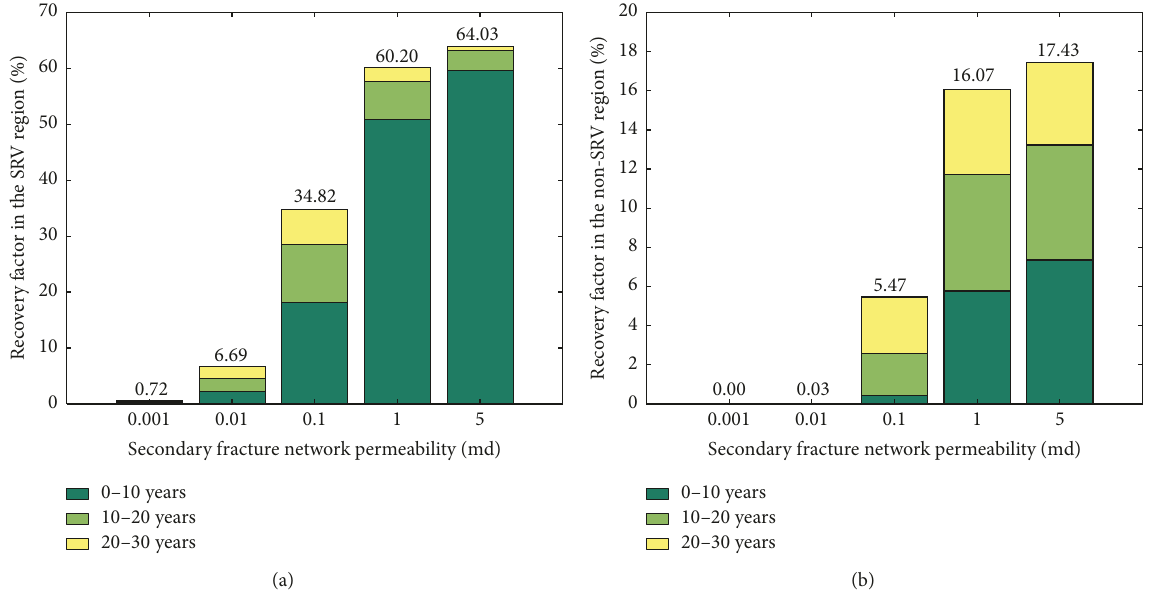
Figure 10: The effect of secondary fracture network permeability on the recovery factor without primary hydraulic fractures: (a) SRV region; (b) non-SRV region.